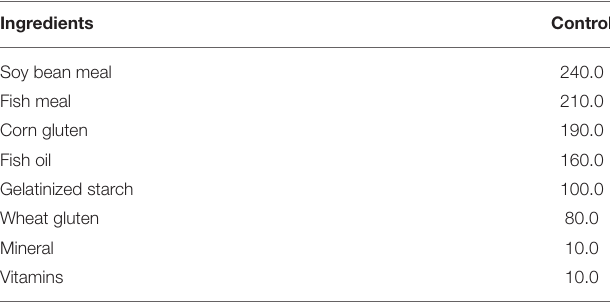
TABLE 1 | Ingredients of control diets provided to Sparus aurata